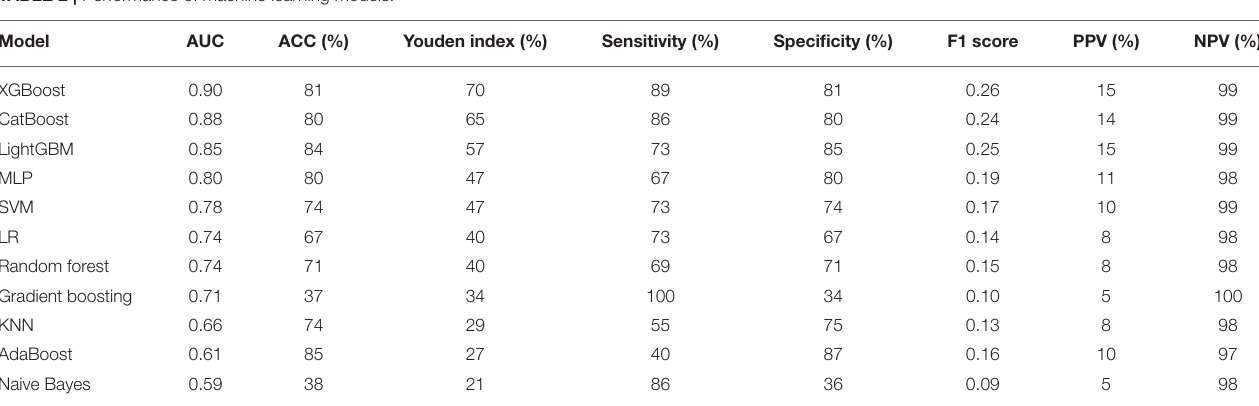
TABLE 2 | Performance of machine learning